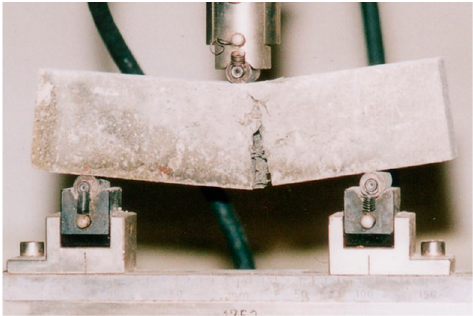
Figure 3. Measurement of the bending strength via three-point bending.